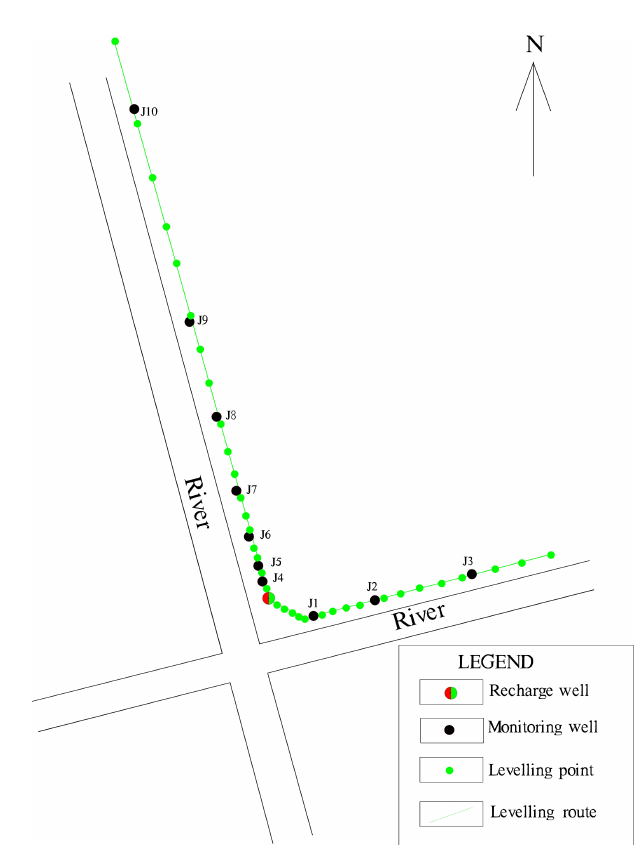
Figure 1. Plan of Recharge Testing Site.